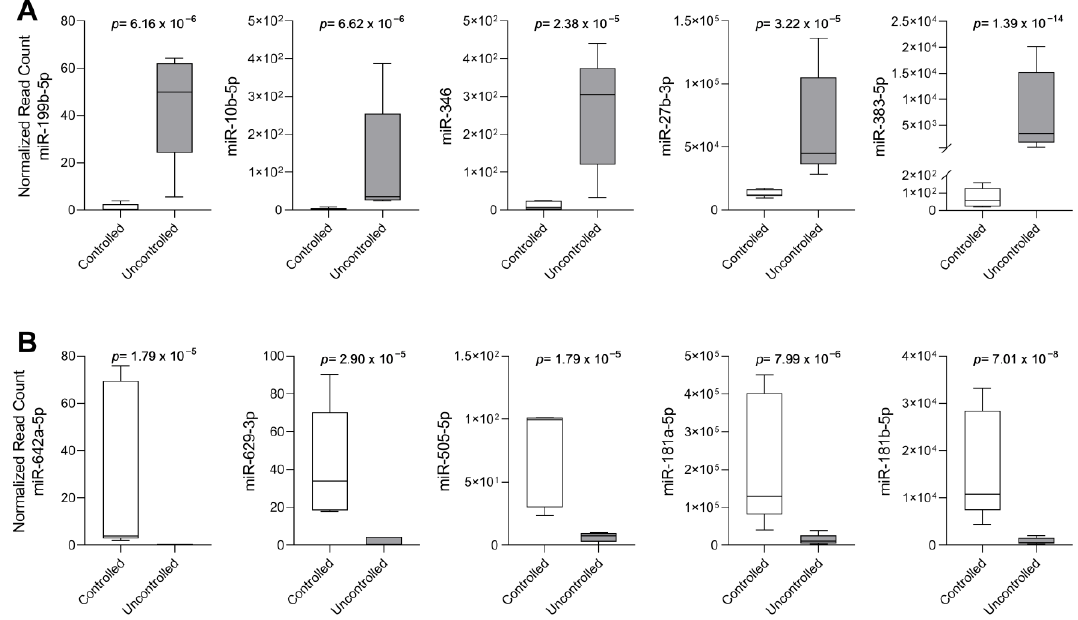
Figure 2. Top 10 differentially expressed miRNAs. Box plot graphs show the miRNAs’ expression according to their normalized read count in each group of patients. ( A ) Overexpressed miRNA in the uncontrolled group. ( B ) Underexpressed miRNA in the uncontrolled group.